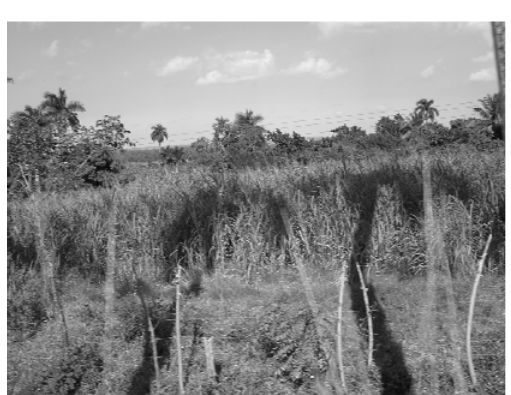
Figure 8. Marabú